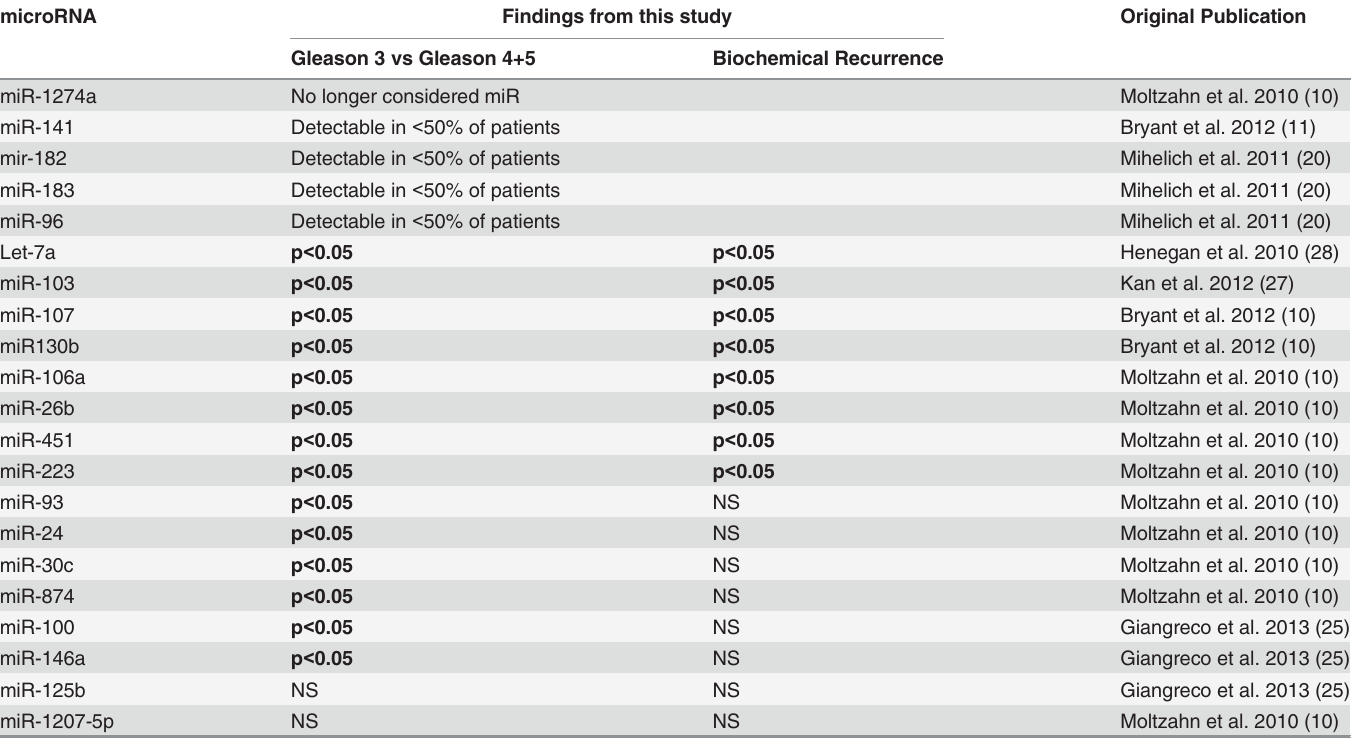
Table 2. miRNAs measured in the serum and delectability in this